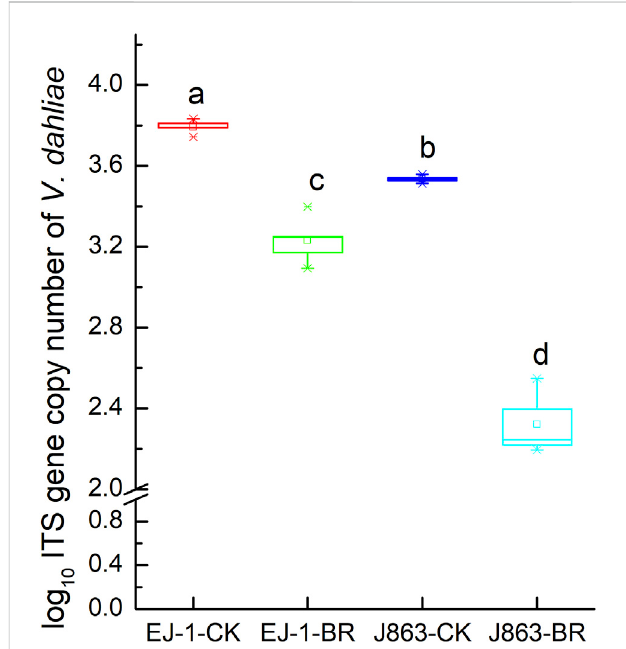
FIGURE 2 Quanti fi cation of V. dahliae in soil by qPCR. CK represents treatment with blank control, BR represents treatment with broccoli residues. EJ-1 represents susceptible cultivar for CVW, J863 represents resistantcultivarforCVW.Barswithdifferentlettersaresigni fi cantly different by Duncan ’ s multiple range test at p <